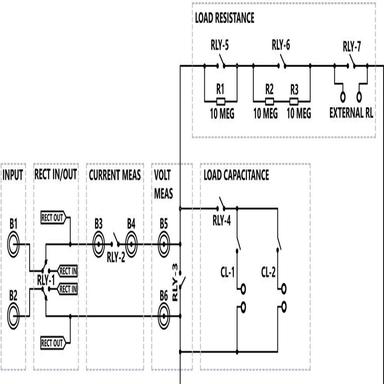
General schematic of the proposed Ddraig Control Board with visible separate sections for output signal from excited piezoelectric sample connection (INPUT), next switch directing the signal to rectifier (RECT. IN/OUT) followed by connectors for ammeter (CURRENT MEAS.) and voltmeter (VOLT MEAS.). The final two sections allow connection of load capacitance for capacitor voltage-time charging curve test (with rectified signal) and load resistance for power delivered to resistive load measurement. .